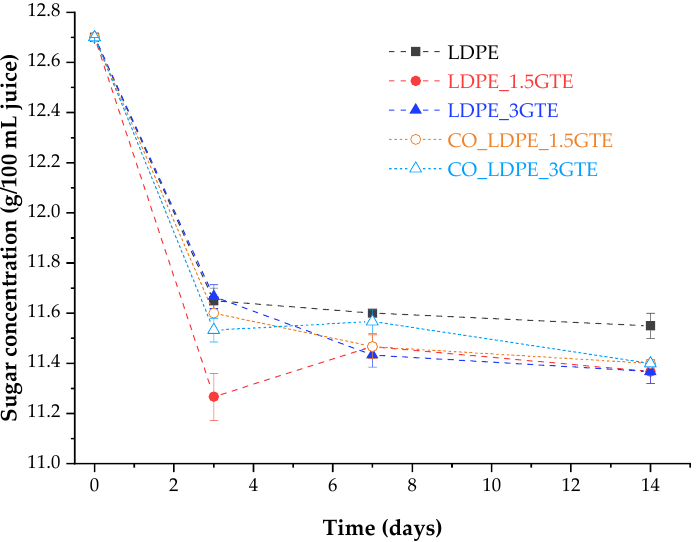
Figure 4. Sugar content in orange juice packed in active LDPE films stored at 4 ◦ C for 14